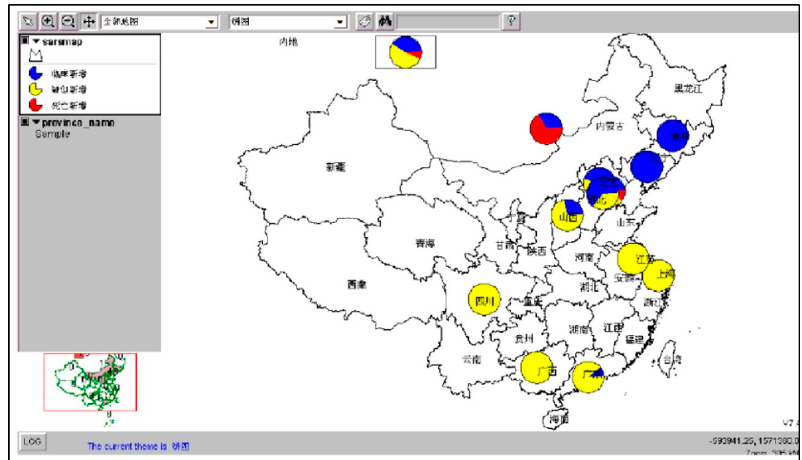
Figure 11. Web-based Geographic Information Systems (GIS) for public health information visualization: distribution map with pie chart to express public health information. (Source: [70]).